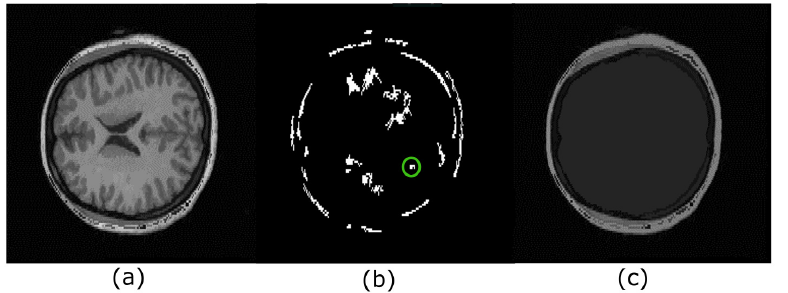
Figure 6. Hyperconnected functions. ( a ) Original image; ( b ) each regional maximum detected corresponds to different regions within the brain, and each maximum can be used to recover other internal structures. However, our work currently investigates this case. The maximum in a green circle is the marker to produce the image in ( c ); ( c ) hyperconnected function associated with regional maximum marked with the green